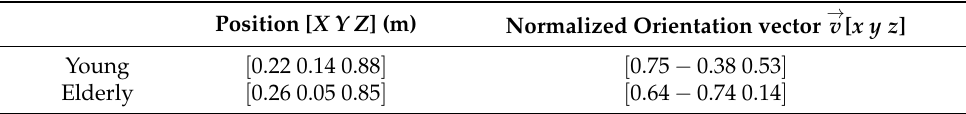
Table 2. Tx positions and orientation vector coordinates on a young and elderly